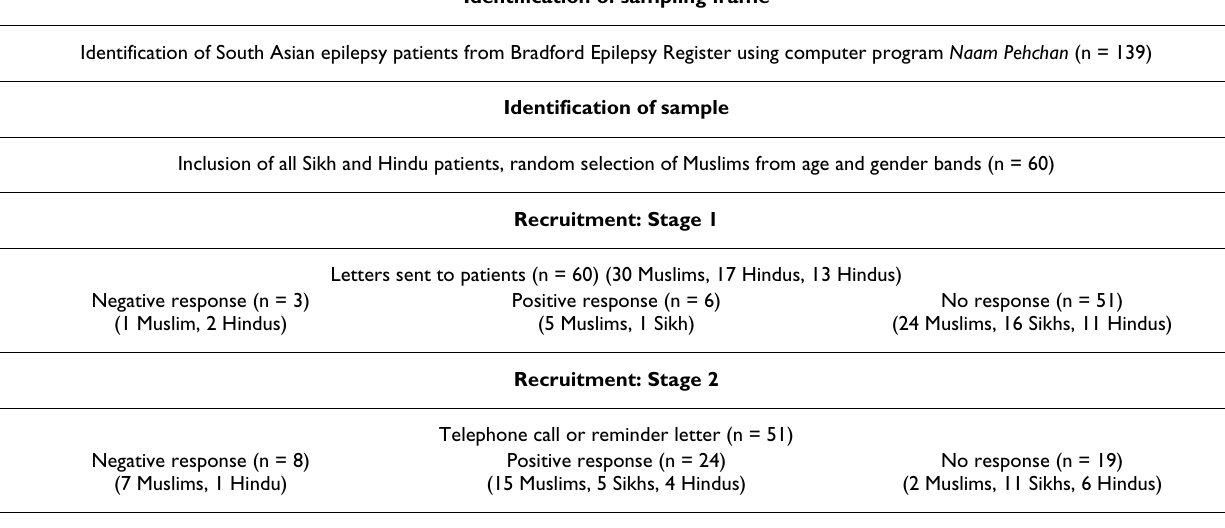
Identification of sampling